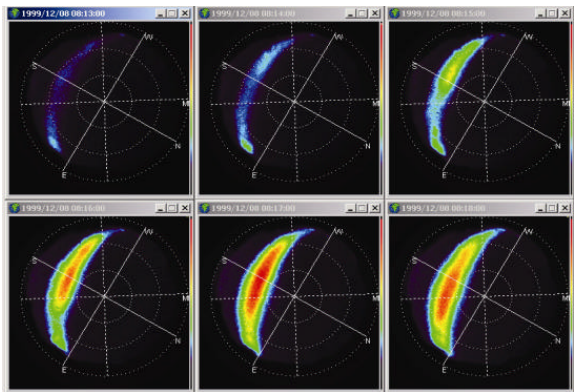
Fig. 7. ASC images at 630.0nm from Ny ˚Alesund, representing the times 08:13:00, 08:14:00, 08:15:00, 08:16:00, 08:17:00, and 08:18:00 UT. The reference grid is zenith angle (circles at 30, 60, 90deg) azimuth angle (straight dashed lines). The MSP scanning meridian (see Fig. 4) is marked north (N) — south (S). The integration time is 2s.